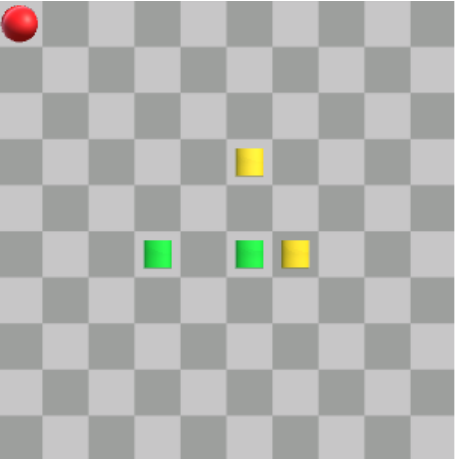
Figure 5. The agent’s environment is a grid world environment. The red circle represents the agent. A cell with a green cylinder increases the life of the agent if it reaches that cell. A cell with a yellow cylinder decreases the life of the agent if it reaches that cell.